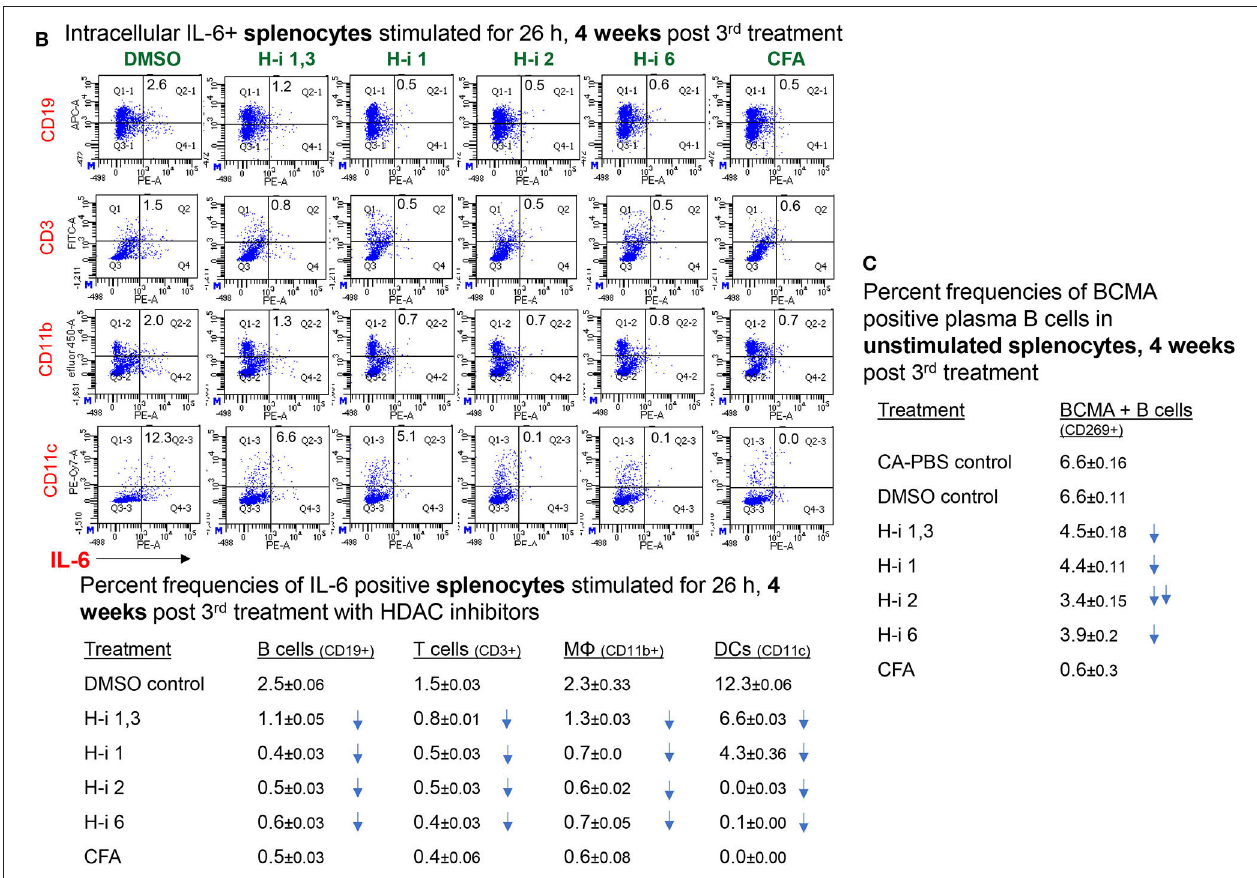
FIGURE 5 | Frequency of (intracellular) IL-6-positive immune cell types. (A,B) CFA ( n = 3) or EAMG mice ( n = 5 per group) treated with HDAC-i were bled 72h and 4 weeks post 3rd treatment for flow cytometric analyses of IL-6-producing cells. Isolated PBMCs and splenocytes were stimulated with AChR in presence of brefeldin for 26h, fixed/permeabilized, and stained with specific fluorochrome-conjugated antibodies to enumerate IL-6-positive immune cell types. (C) An aliquot of splenocytes from EAMG mice (isolated 4 weeks post 3rd treatment) treated with HDAC-i and not stimulated but Fc-blocked and stained with BCMA-specific monoclonal Ab (Ray Biotech) and PE-conjugated secondary Ab. The numbers below the figures summarize the percent frequency changes of immune cells. Shown on the right are the percent frequencies of BCMA-expressing cells. The experiment is representative of three similar experiments. Three replicates of pooled samples per group were used for flow